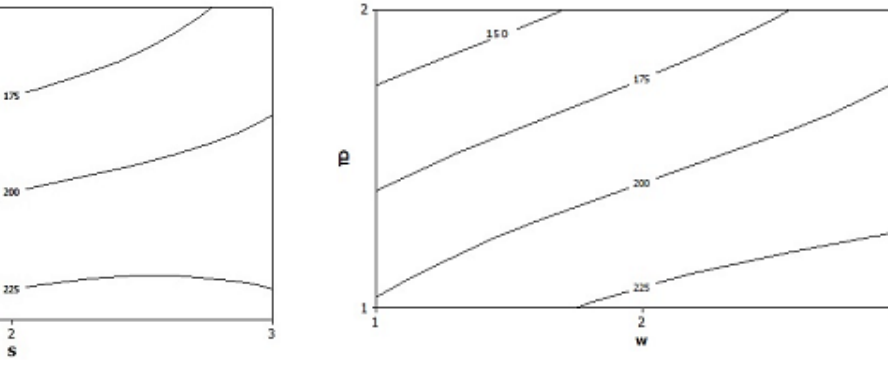
Fig. 6. Counter diagram of average water droplet size change in terms of the demulsifier types and water